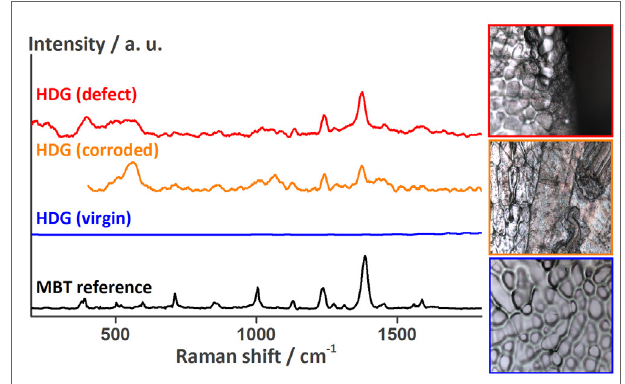
FigUre 9 | raman spectra recorded at the hDg surface underneath the coating around the defect showing the release of MBT from the lDh containers onto hDg . The optical images to the right (side length about 100 μ m) show the surface at the location of the measurements [top: HDG (defect), middle: HDG (corroded), and bottom: HDG